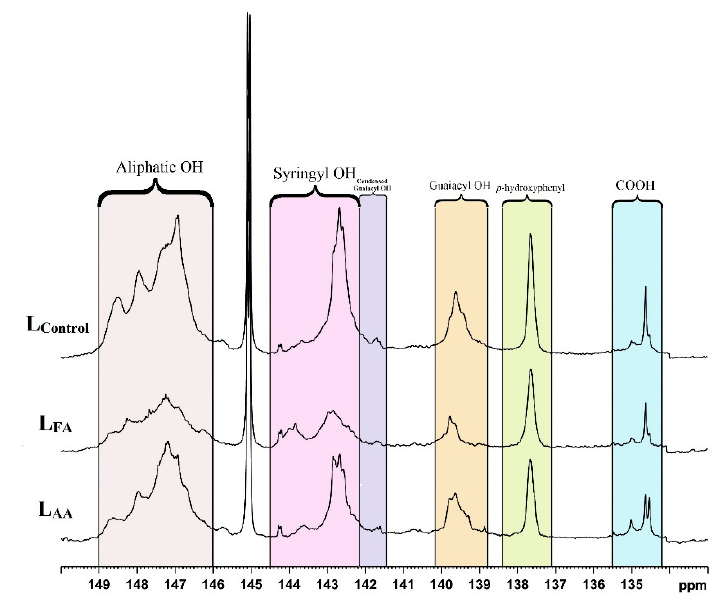
Figure 3. 31 P-NMR spectra of the lignin polymers obtained by different conditions. All the lignin samples were obtained from 40–60 meshed poplar wood and extracted under conditions without aldehyde, with FA, and with AA. Table 3. Quantification of different OH groups in the lignin fractions by 31 P-NMR (mmol/g). Samples